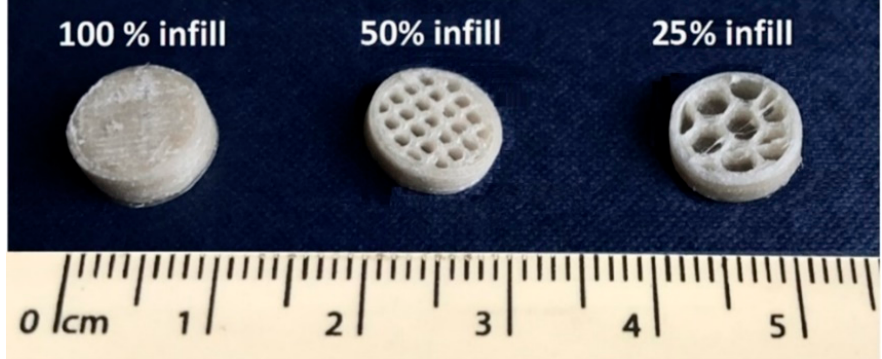
Figure 7. Horizontal cross sections of C40 with three infill percentages (100, 50, and 25% v / v ).